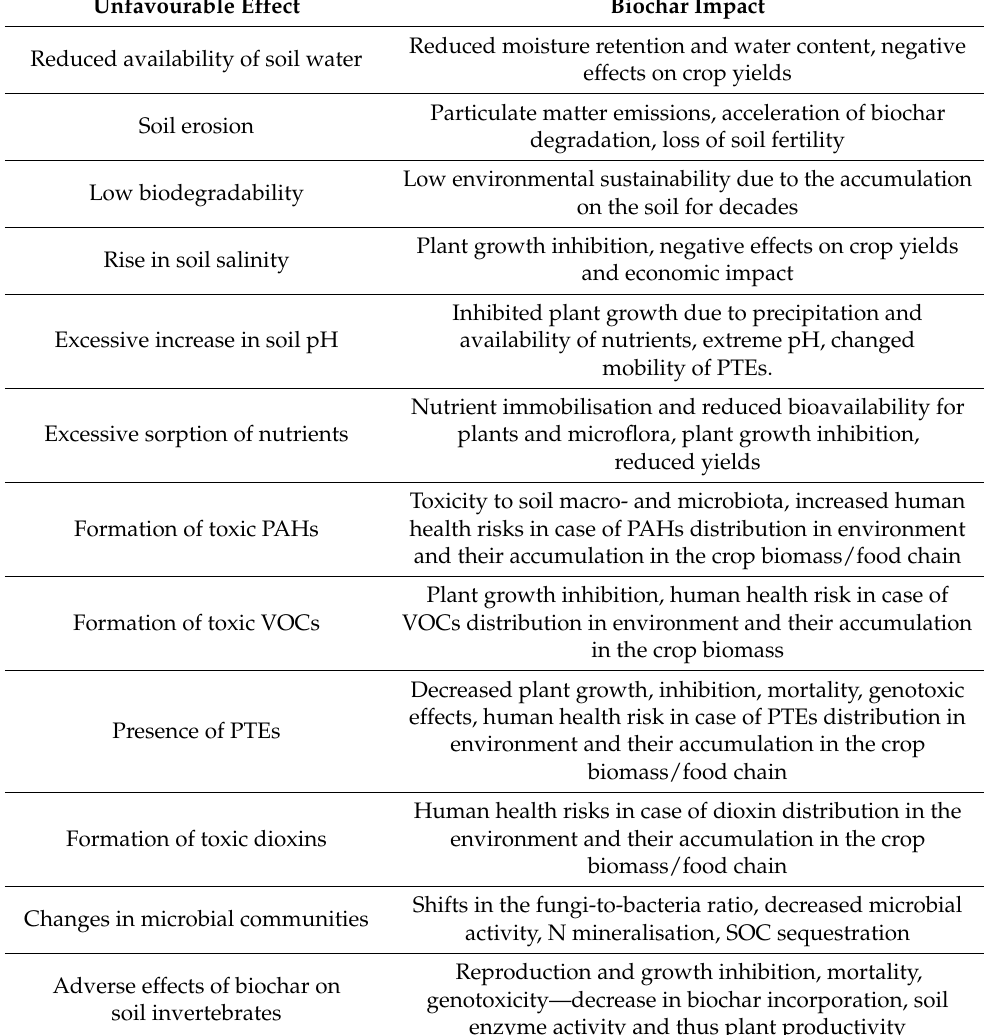
Table 5. Biochar impact on water, erosion and soil salinity